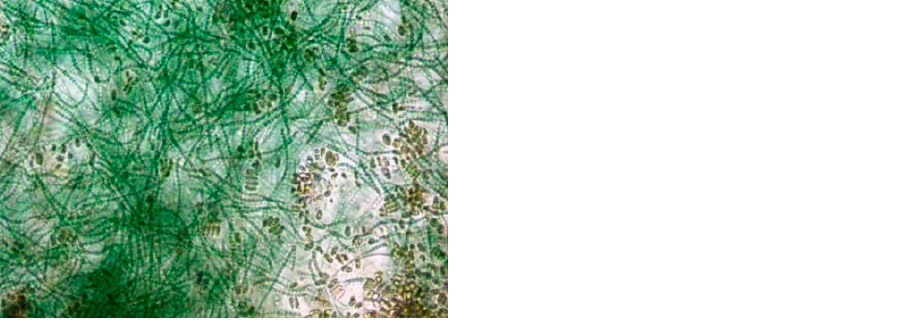
Figure 8. Biofilm on the surface of the Holešov-Žopy bricks. The photo was taken under the light microscope Olympus BX43 with a CMOS camera (magnification 400×). Table 3. Biological experiment with the Vysoké Mýto and Holešov-Žopy bricks. Biofilm density on the surface of samples expressed by absorbance values.